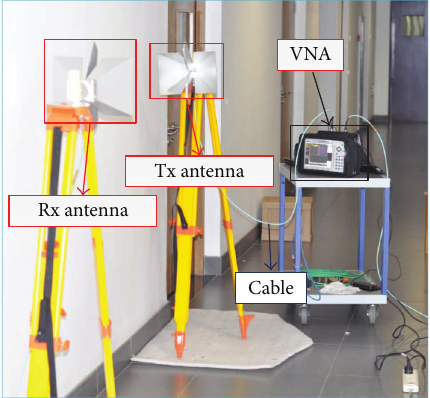
Figure 4: Measurement system with Tx, Rx, VNA, and cable.